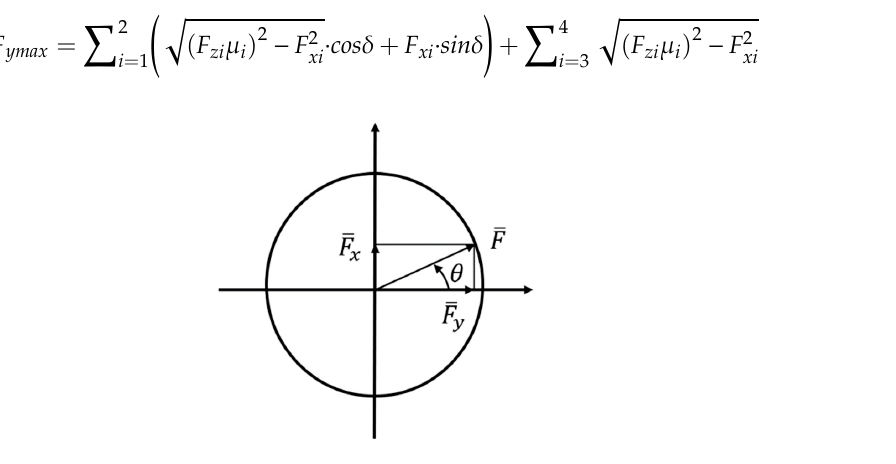
Figure 5. Friction circle diagram.